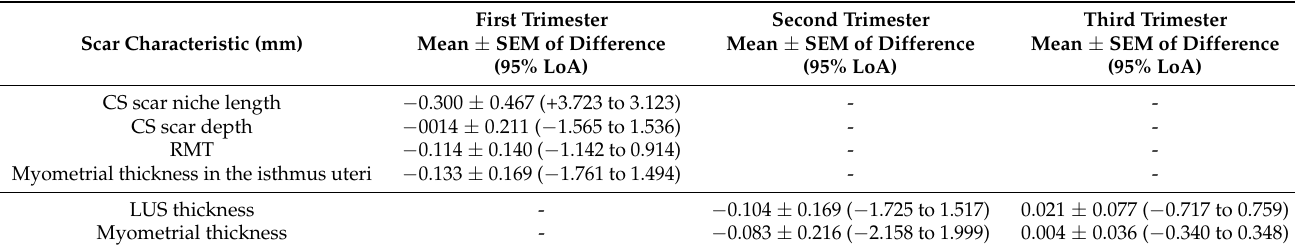
Table 3. Mean ( ± SEM) of differences between and 95% limits of agreement (LoA) for CS scar niche and low uterine segment measurements by two researchers across all three trimesters ( n = 24).